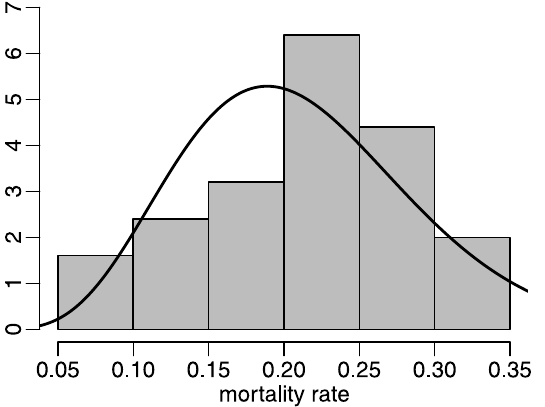
Fig 7. Histogram and fitted beta density, period 2, state